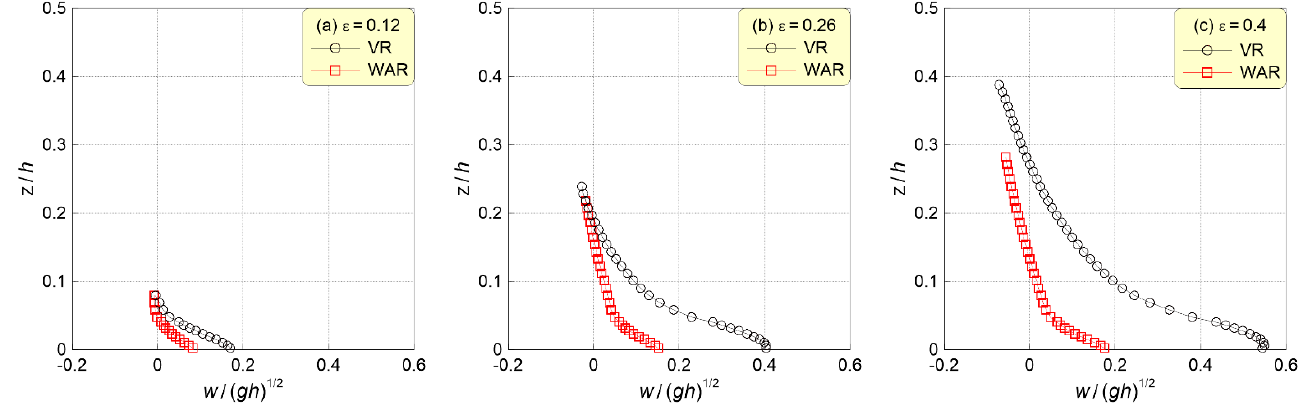
Figure 21. Vertical distribution of vertical velocity at the center of the separated region — comparison between VR and WAR; ( a ) 𝑥 ℎ = 0.04; (𝐛) 𝑥 ℎ = 0.11; (𝐜) 𝑥/ℎ = 0.15 . 5.3. Vortex Field To analyze the vortex phenomenon in the solitary wave overtopping and inundation process at the VR and WAR, Figures 22 and 23 show the vortex fields at 𝑡 ∗ = 0 when the maximum water surface elevation occurs at the vertical wall edge. The solitary wave in- cidence conditions of Run-2 ( 𝐴 0 = 5.4 cm , 𝜀 = 0.12 ), Run-7 ( 𝐴 0 = 12.3 cm , 𝜀 = 0.26 ), and